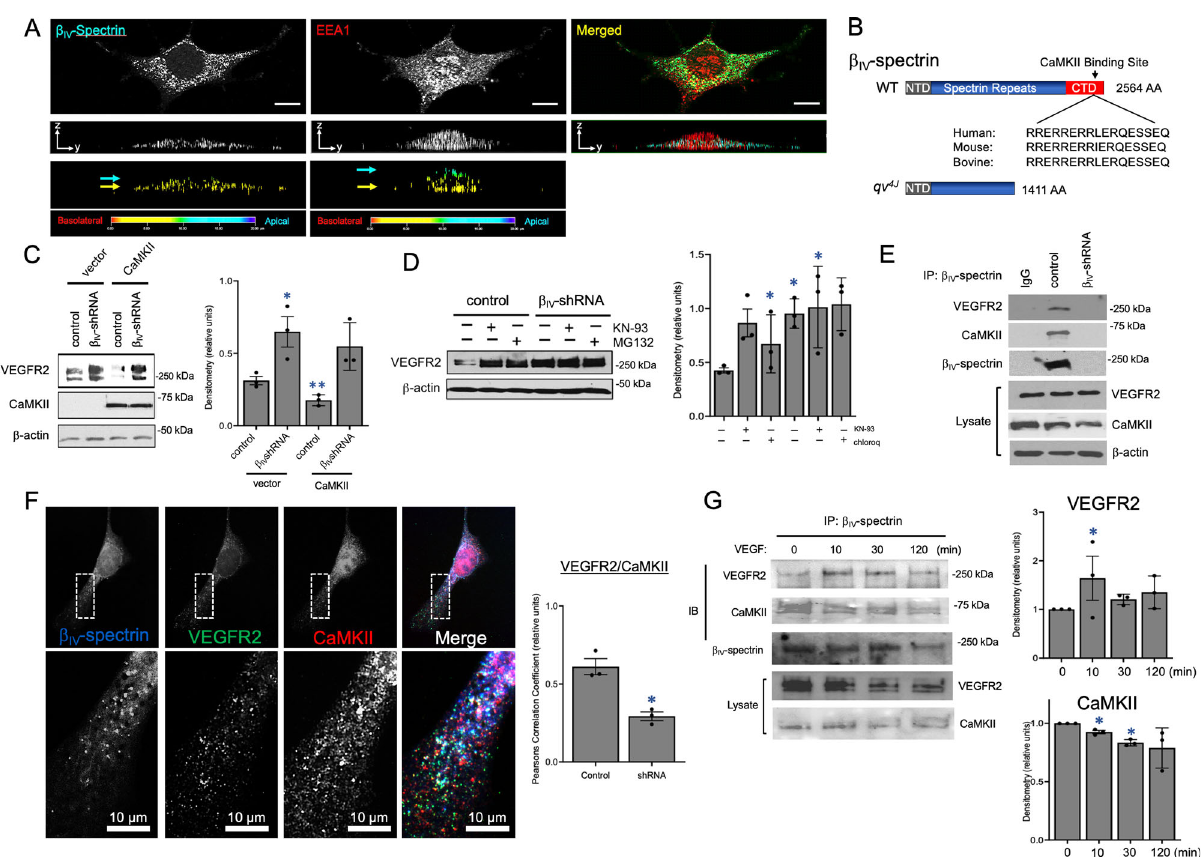
Fig. 4 β IV -spectrin recruits CaMKII to form a trimeric complex with VEGFR2 to promote VEGFR2 turnover. A Confocal Z-stack image analysis shows endogenous β IV -spectrin localization in punctate clusters (green) that localize at the basolateral membrane (yellow arrows and clustered staining correspond to basolateral polarity in topology heat map). EEA1 (red) shows both membrane and cytoplasmic localization as indicated by green and yellow arrows and topology heat map. B Schematic of WT and β IV -spectrin mutant, qv4J, which lacks the C-terminal domain containing CaMKII-binding site. The peptide sequence showing the precise CaMKII-binding site is conserved. C Western analysis of total VEGFR2 and CaMKII expression in control and β IV - shRNA MEECs upon transfection with vector control or CaMKII α . Densitometry quanti fi cation representative of three independent experiments,